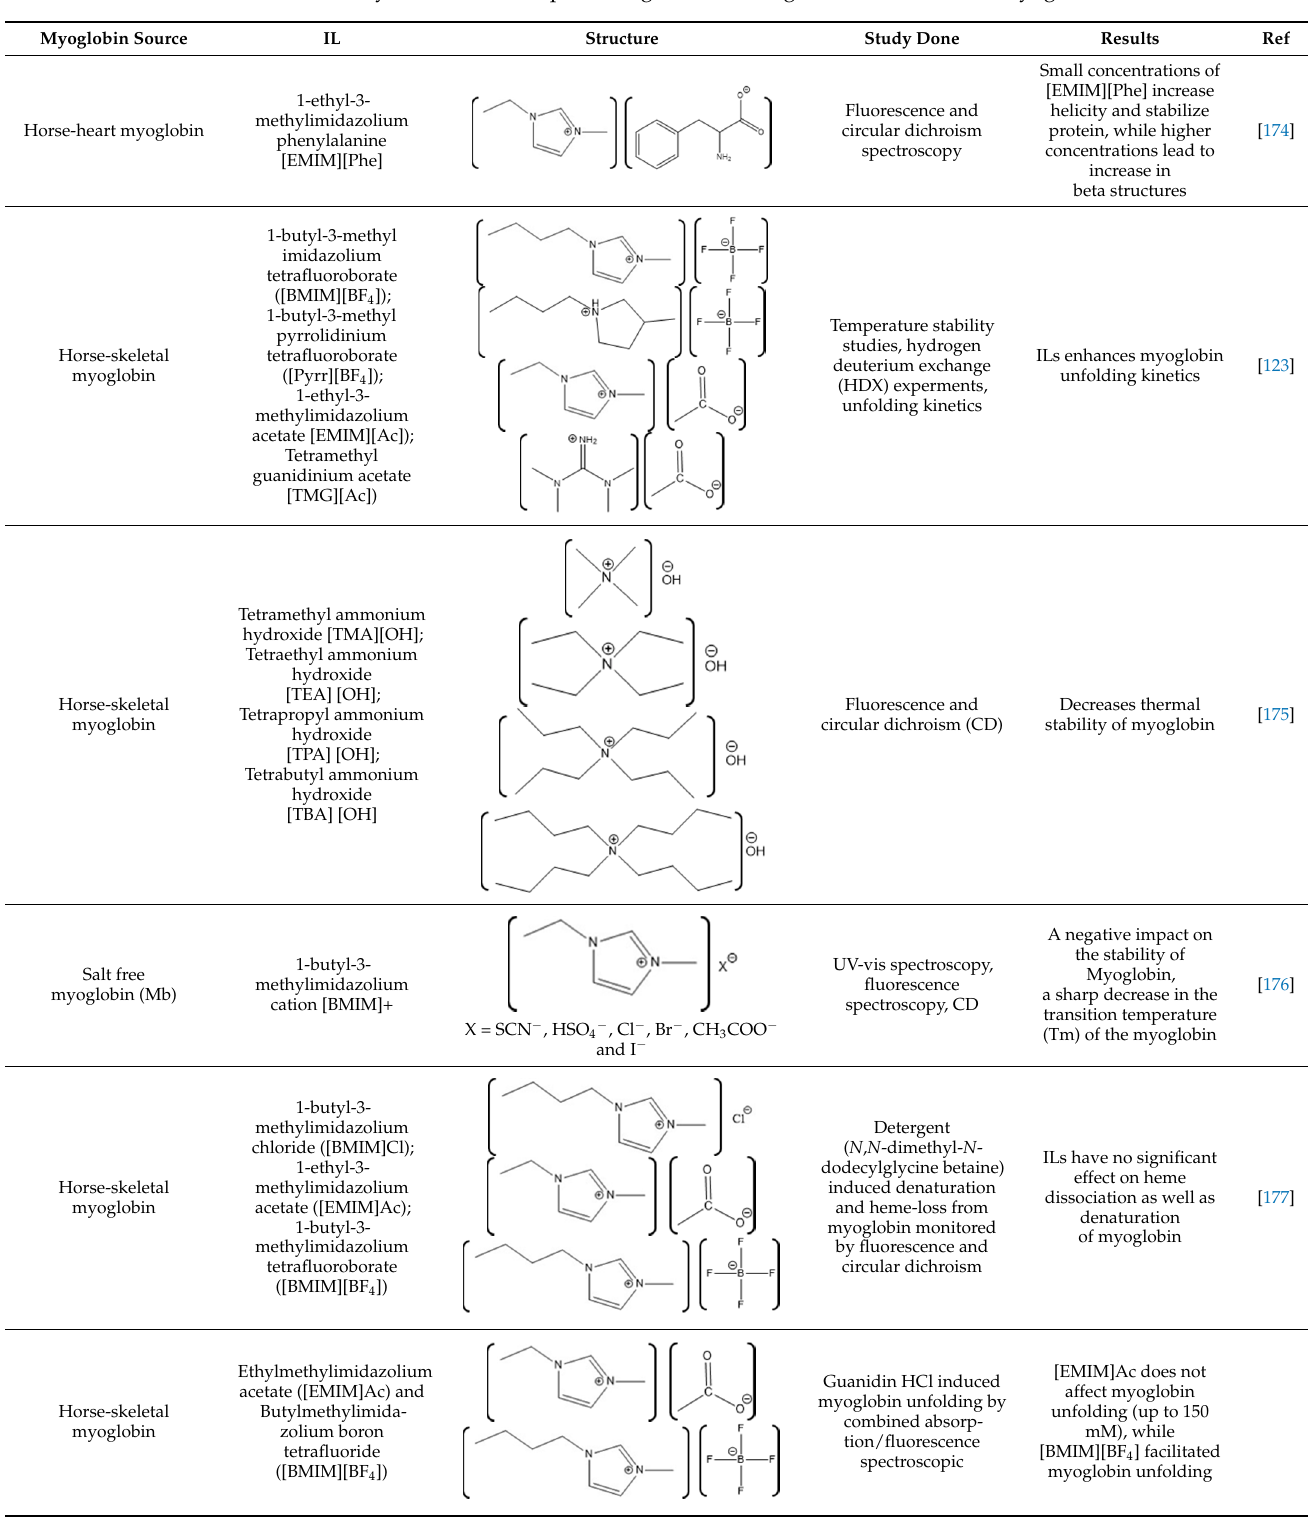
Table 2. Summary of studies done pertaining to monitoring the effects of ILs on myoglobin.